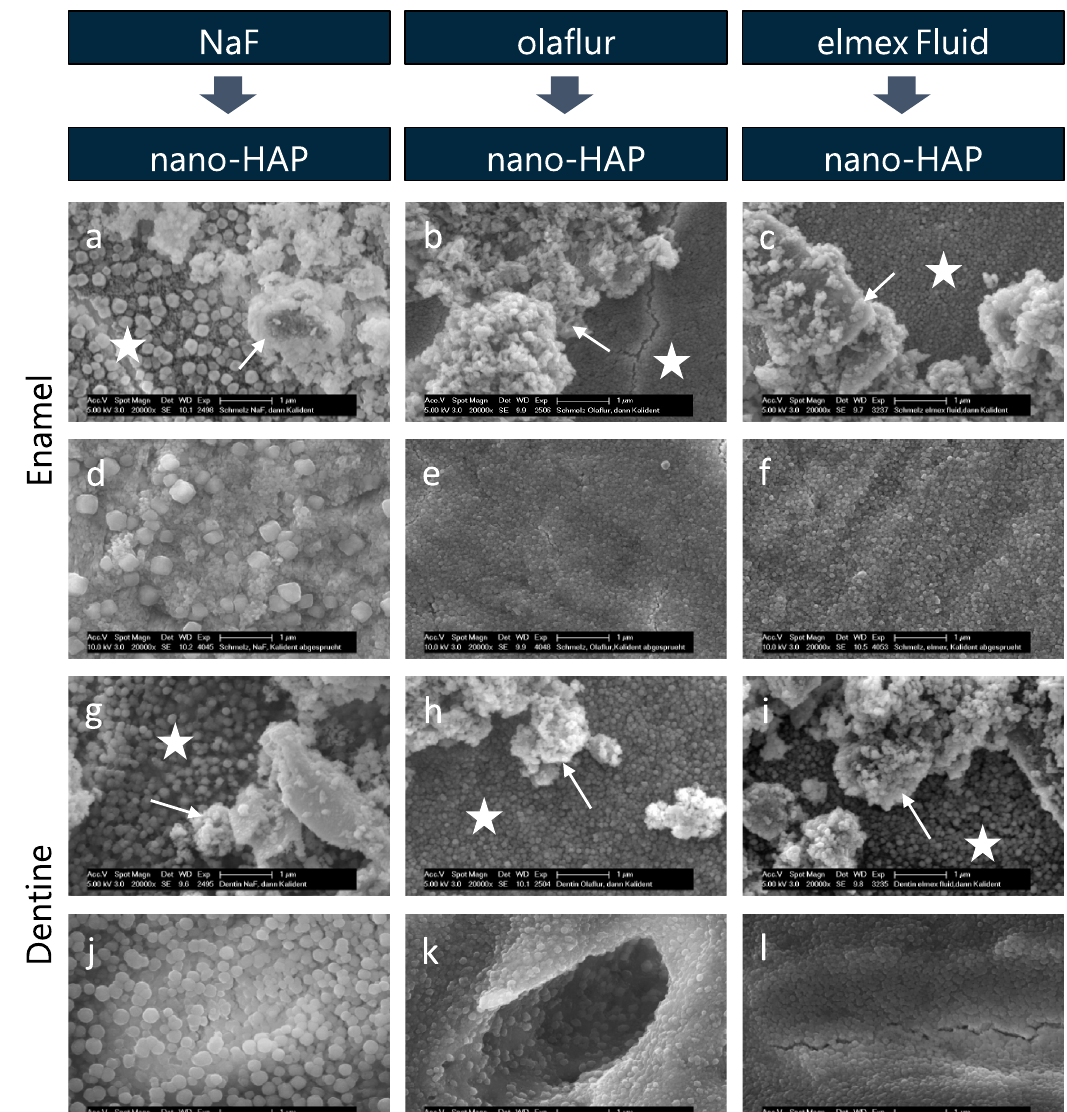
Figure 6. SEM figures at 20,000-fold magnification of enamel ( a–f ) and dentine ( g–l ) samples after 5 min primary incubation in sodium fluoride ( a,g ), olaflur ( b,h ), elmex Fluid ( c,i ) and 5 min secondary incubation in aqueous nano-HAP solution and subsequent 20 s spraying with the multifunctional syringe ( d–f,j–l ). The images reveal an inhomogenous coverage of the fluoridated surface with nano-HAP particles of different size and shape. White asterisks mark the surface masked with globules. White arrows point to accumulated nano- HAP particles with the tendency for clusters formations. After spraying, a surface homogenously covered with globular precipitates is visible. The nano-HAP particles are completely washed off. Nano-HAP hydroxyapatite nanoparticles, NaF sodium